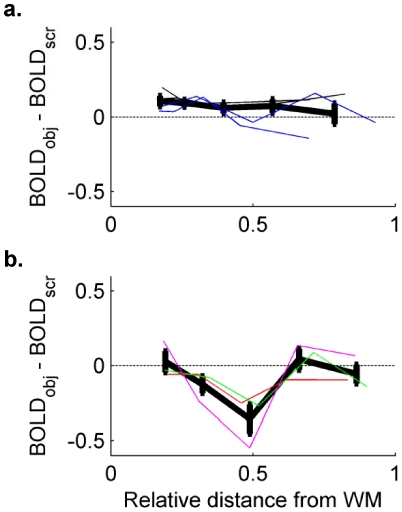
Differential laminar profiles of clusters sorted according to whether the average response to intact or scrambled objects was greater.a.) Regions of interest responding more strongly to intact objects were observed in 4 scanning sessions (colors of thin trace indicate different subjects). No main effect of depth is observed, although there is a statistically insignificant pattern of stronger responses to objects in deeper layers. b.) Regions of interest responding more strongly to objects were observed in 3 scanning sessions.